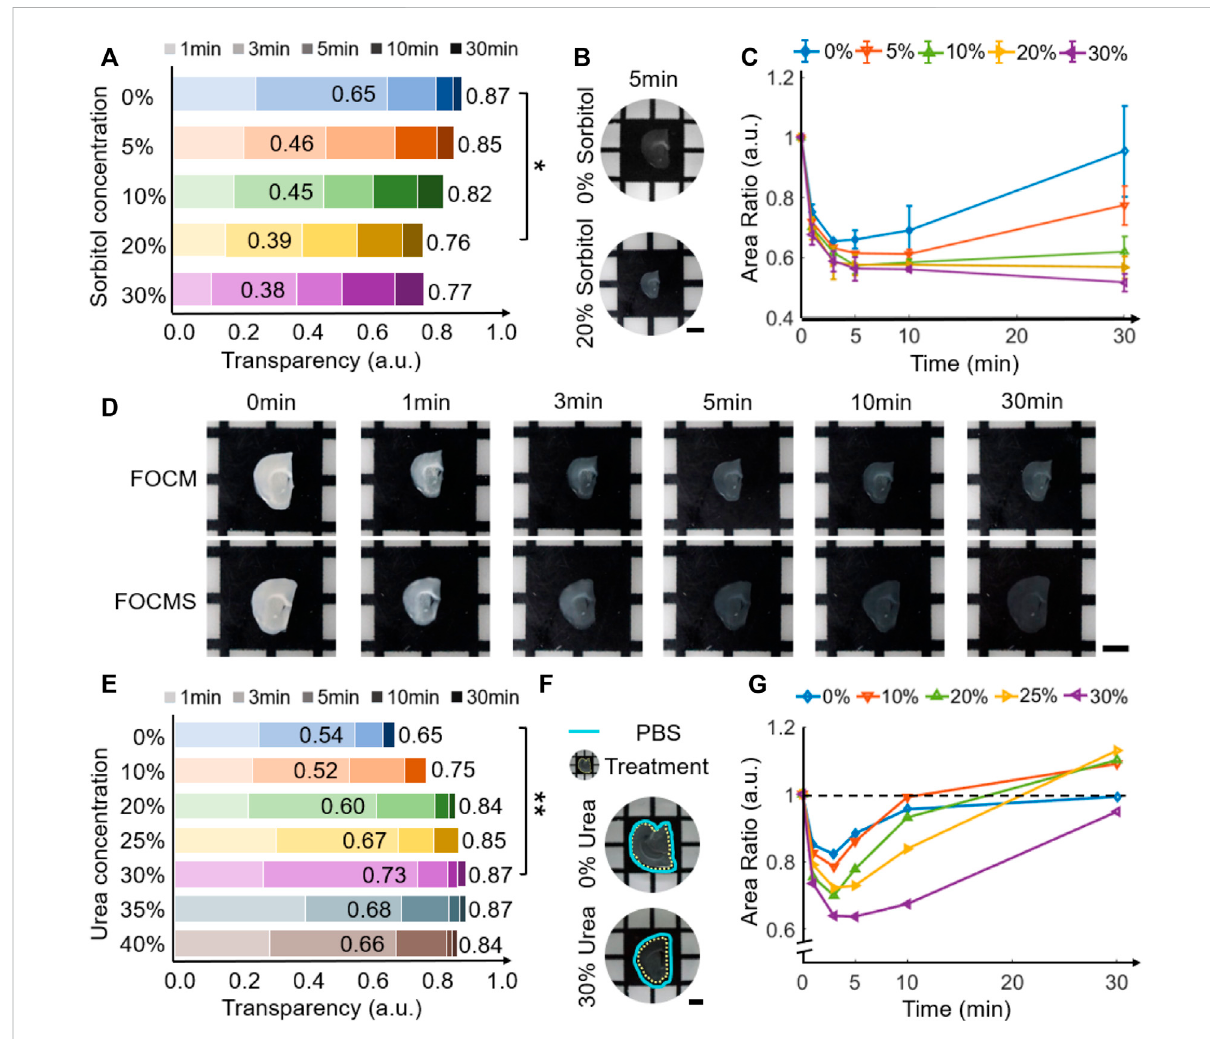
FIGURE 2 FOCM and FOCMS concentration gradient screening. (A) Variation of transparency with different sorbitol concentrations in FOCM reagent. (B) Comparison of transparency of brain slices using FOCM reagent with sorbitol concentration of 0% and 20% wt/vol for 5 min. (C) Changes of brain tissue area with sorbitol concentration in FOCM reagent. (D) Comparison of optical clearing effects between FOCM and FOCMS at 0 min, 1 min, 3 min, 5 min, 10 min and 30 min (E) Variation of transparency with different urea concentrations in FOCMS reagent. (F) Morphology caused by FOCMS reagents. The cyan solid line is the slice boundary before optical clearing, and the yellow dotted line is after optical clearing. (G) Changes of brain tissue area with urea concentration in FOCMS reagent. Scaler bar: 2 mm, statistical signi fi cance (** p < 0.01, * p <